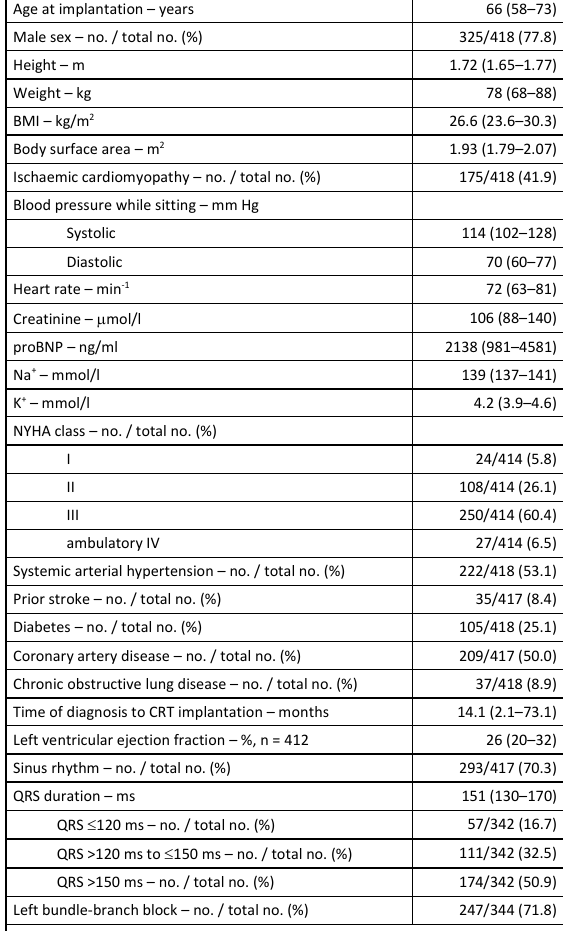
Table 1: Patient characteristics at baseline (the time of cardiac resynchronisation therapy